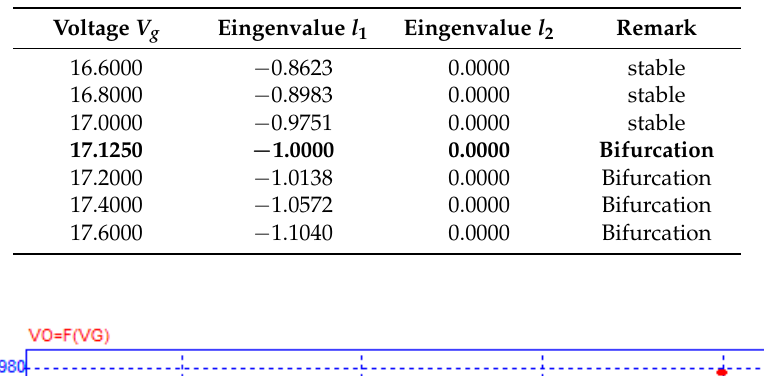
Table 2. Characteristic multipliers of the boost converter for increasing values of the voltage V g . The bold value in the first column denotes the threshold when bifurcation occurs.